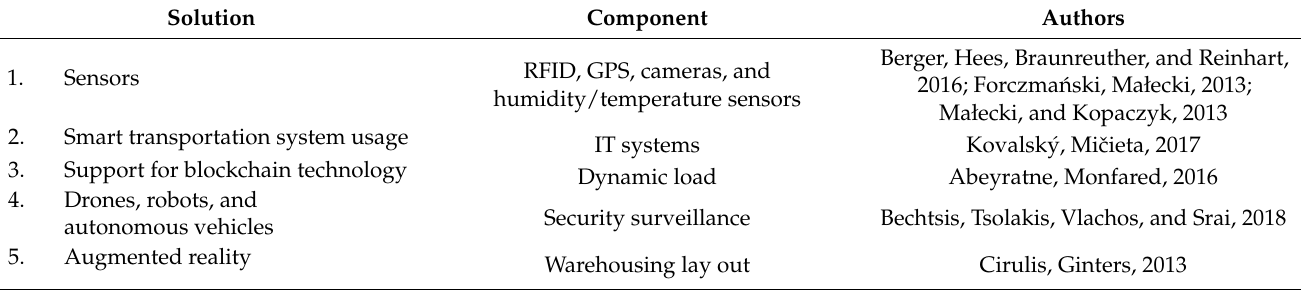
Table 8. Solutions in Logistics 4.0